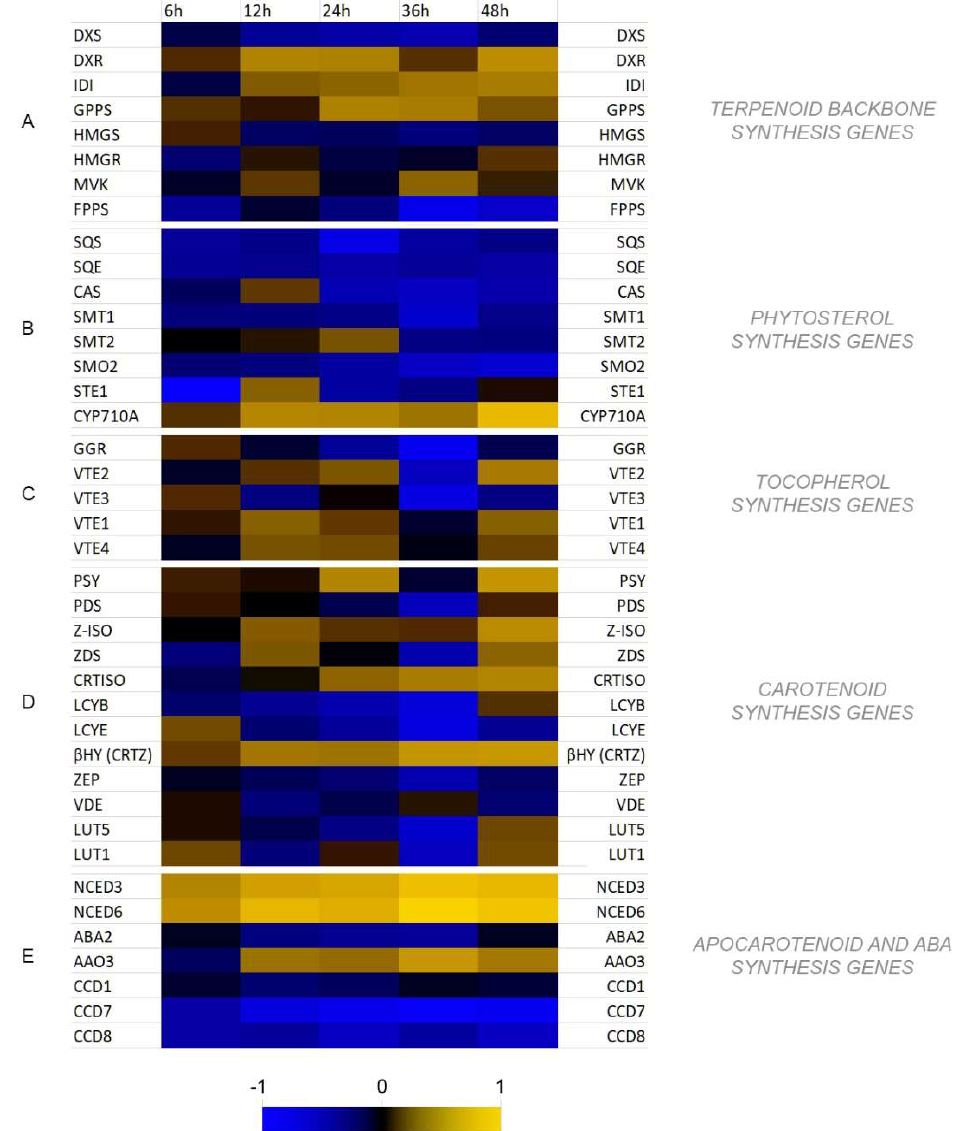
Figure 3. Heatmap of terpenoid pathway key gene expression in flax after F. culmorum infection (x—fold of the control). ( A )—terpenoid backbone synthesis genes; ( B )—phytosterol synthesis genes; ( C )—tocopherol synthesis genes; ( D )—carotenoid synthesis genes; ( E )—apocarotenoid and ABA synthesis genes. Detailed results on the expression can be found in Supplementary File S3.